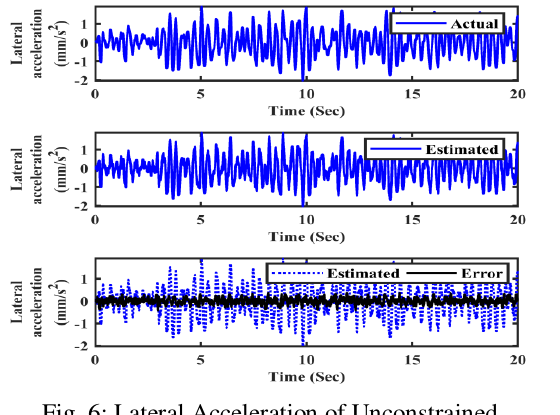
Fig. 6: Lateral Acceleration of Unconstrained Wheelset ( Λ ) W = 0.15